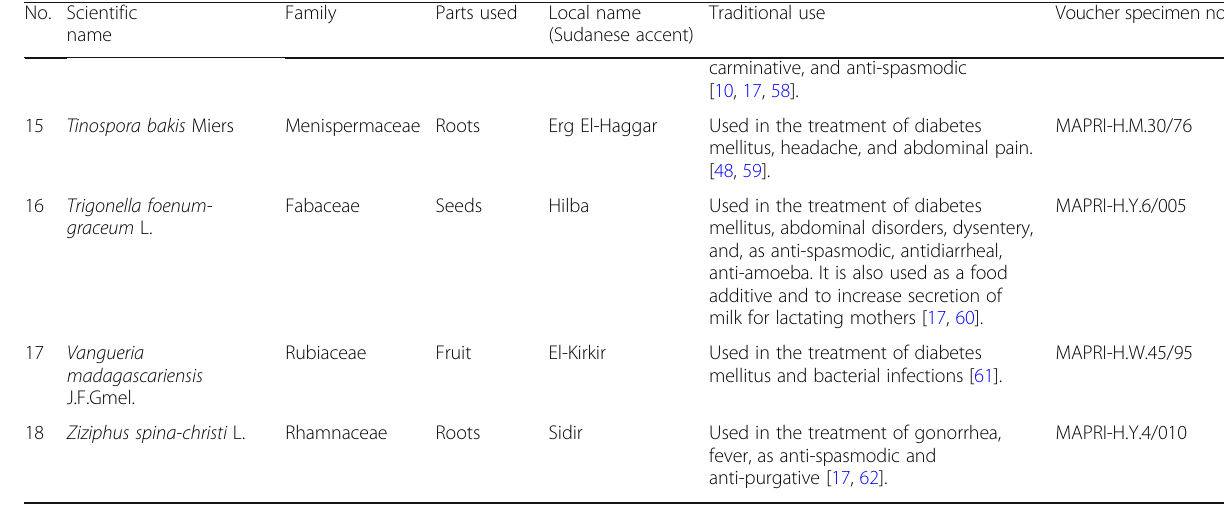
Table 1 Scientific name, family, parts used, local name, traditional use and voucher specimen number of species under